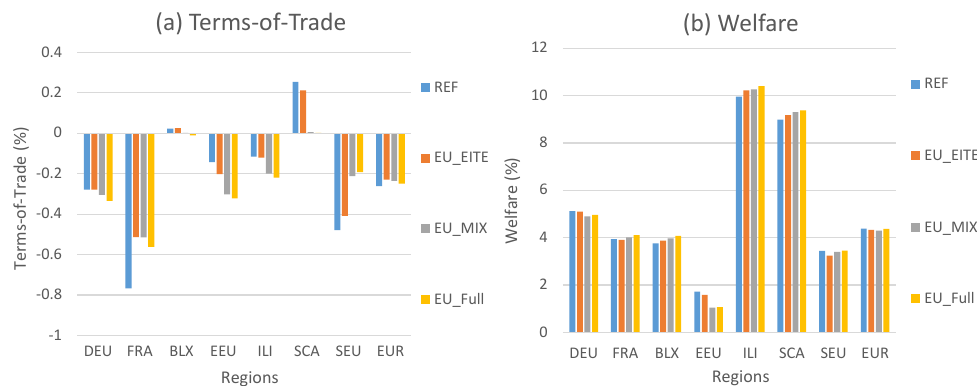
Figure 11. Percentage change in ToT and wefare for different policy scenarios using the WEO baseline against the IEO